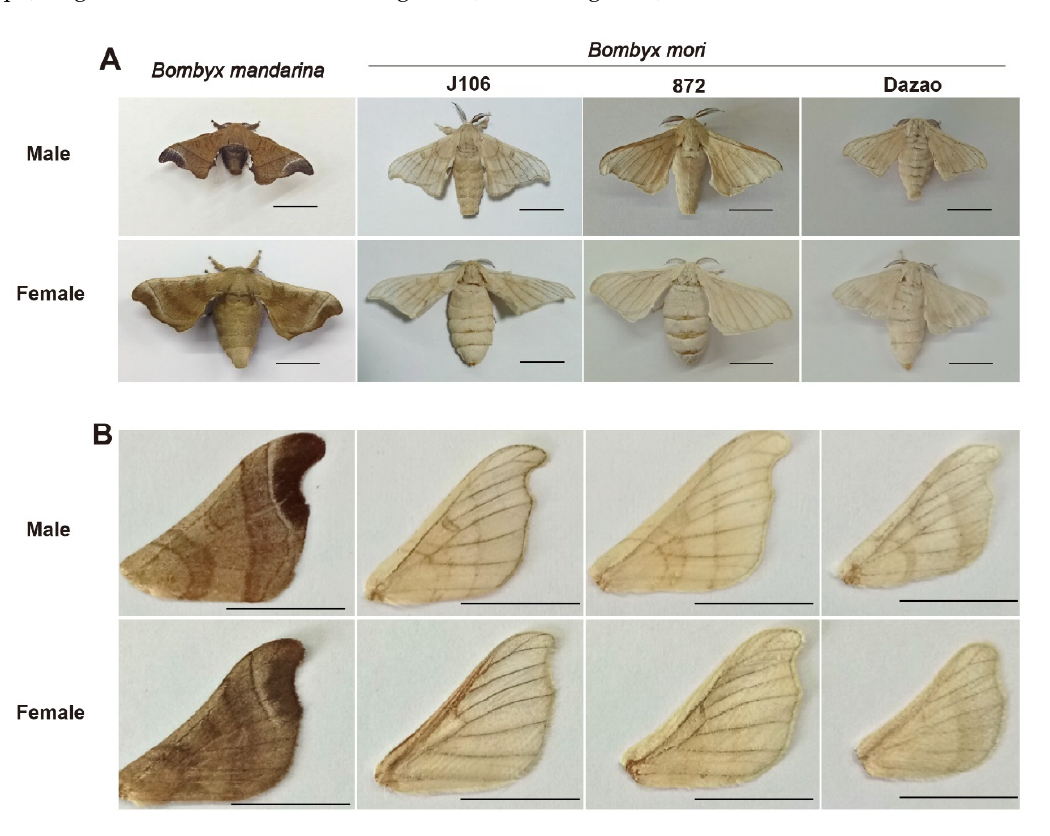
Figure 2. Body weight (mg), wing loading and flight muscle ratio of silkmoths. The five points of box- plot from top to bottom represent the maximum value, the 75th percentile, the 50th percentile (median), the 25th percentile and the minimum value. The box color from light orange to dark red represent B. mandarina , J106, 872 and Dazao, respectively. The X -axis of the above figures were the same as the bottom. We compared B. mandarina to J106, 872, Dazao, respectively using ANOVA.